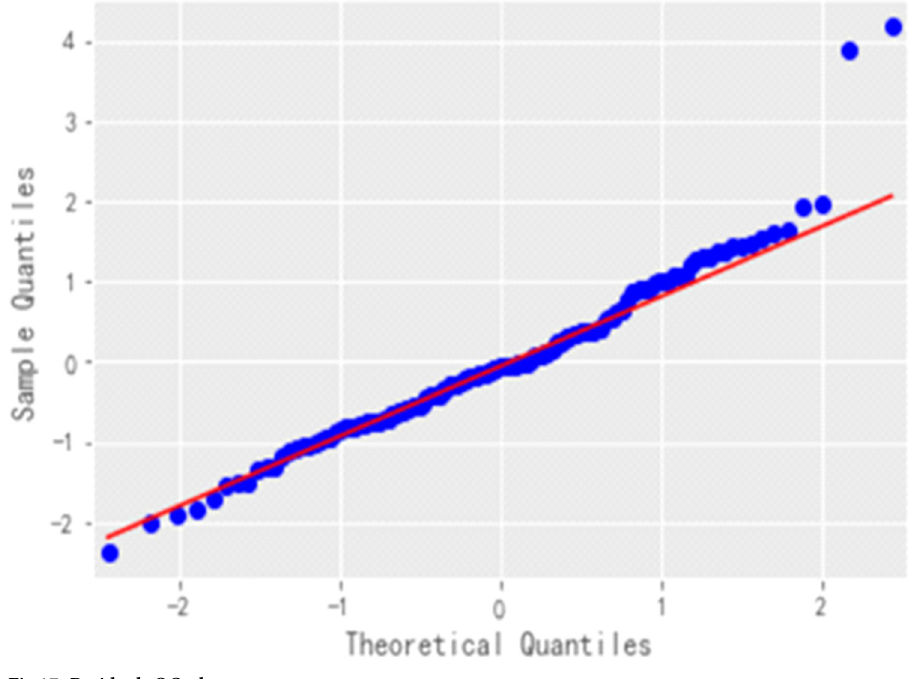
Fig 17. Residuals QQ